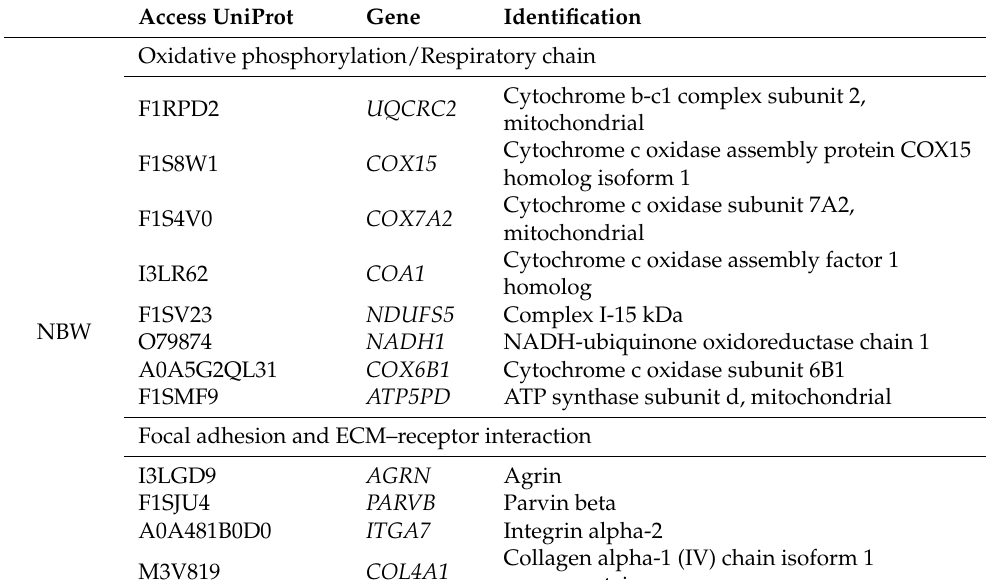
Table 5. Differentially abundant proteins identified in NBW and LBW animals subjected to Ctrl and HFD diets. In red: Upregulated in HFD versus Ctrl. In Green: Down-Regulated in HFD versus